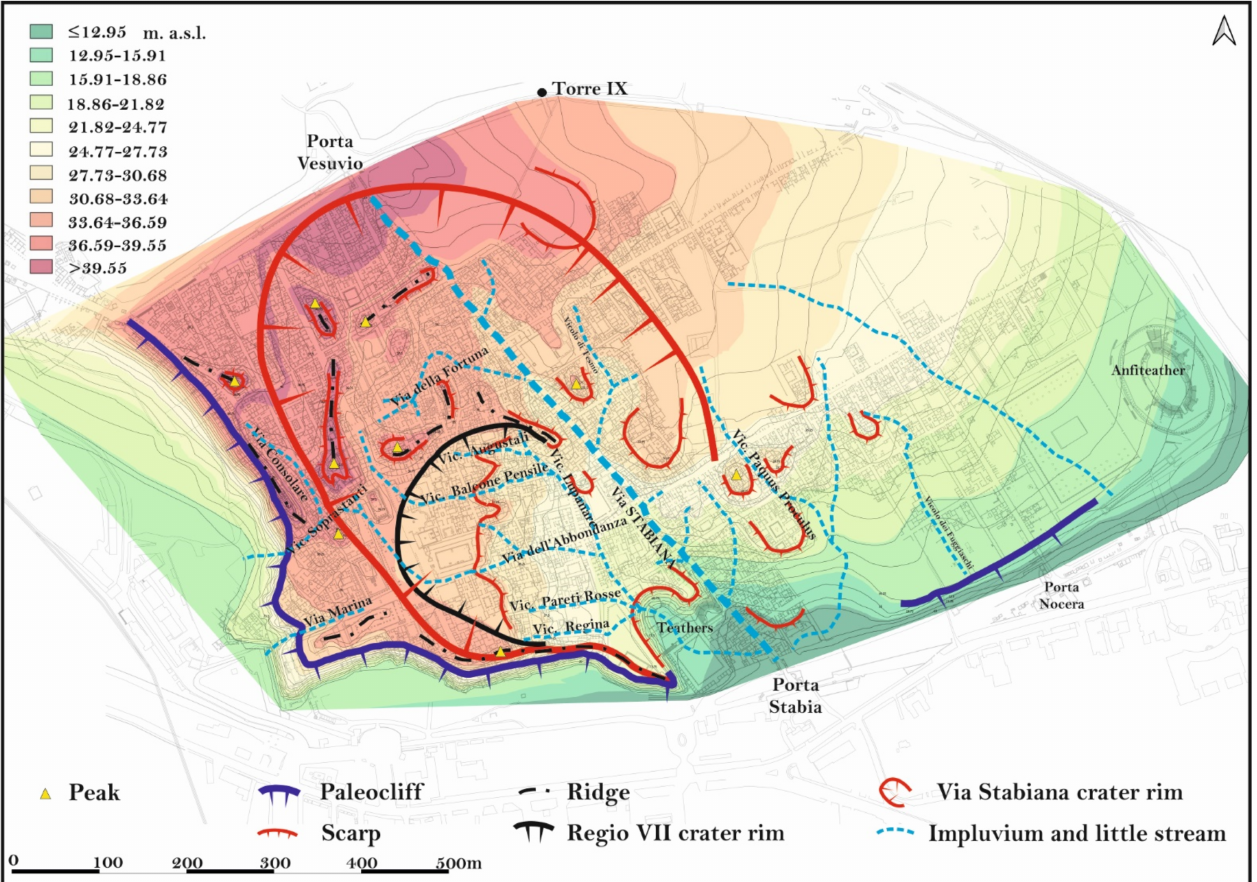
Figure 6. Geomorphological map of the Pompeii ancient city overlayed onto digital terrain model (DTM). In the eastern sector, the scarp of the paleocliff is lower than the western and southern sectors, presenting also fewer steep